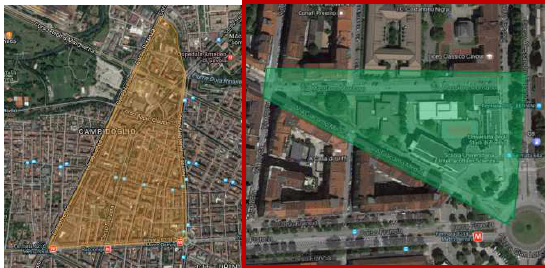
Figure 3. The Campidoglio district (left) and the buildings block selected for the air quality analyses (right).